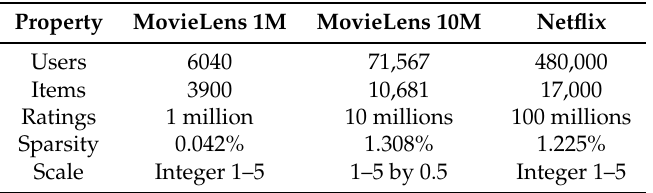
Table 2. Properties of different movie datasets.